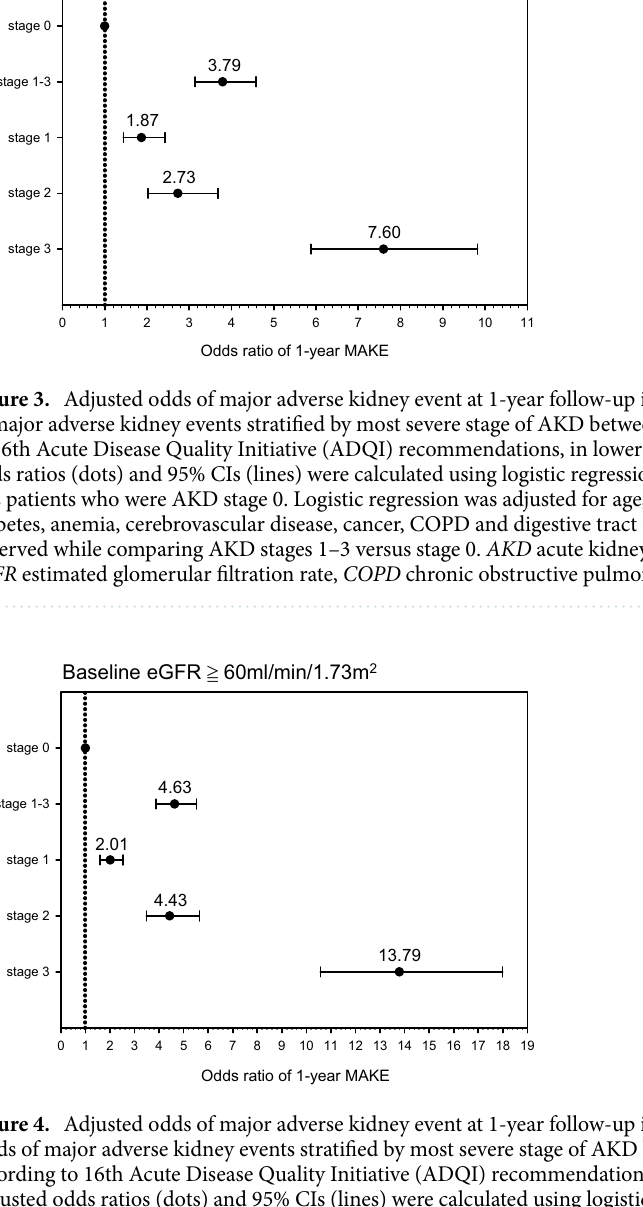
eGFR group) across all clinical settings (all EMR data in our analysis comprised data from hospitalized patients and outpatient clinic patients). Different stages of post-AKI AKD have diverse clinical outcomes. Notably, international experts have achieved a consensus regarding AKD staging 2 , recommending a clinical classification based on SCr data. The criteria of post-AKI AKD stages are congruent with the KDIGO guidelines on AKI stages. Chen et al. studied a cohort of patients on extracorporeal membrane oxygenation and observed that AKD stages were independent risk factors for mortality 22 . In the present study, we further delineated the prognostic effects of different AKD stages related to various MAKEs. Regarding MAKEs at 1 year, a more severe AKD stage was noted to be associated with worse kidney outcomes. Moreover, the risk of 1-year MAKEs seemed to increase in direct proportion with AKD stage. AKD was also associated with an increased risk of in-hospital mortality, both in the lower baseline eGFR and the higher baseline eGFR groups.